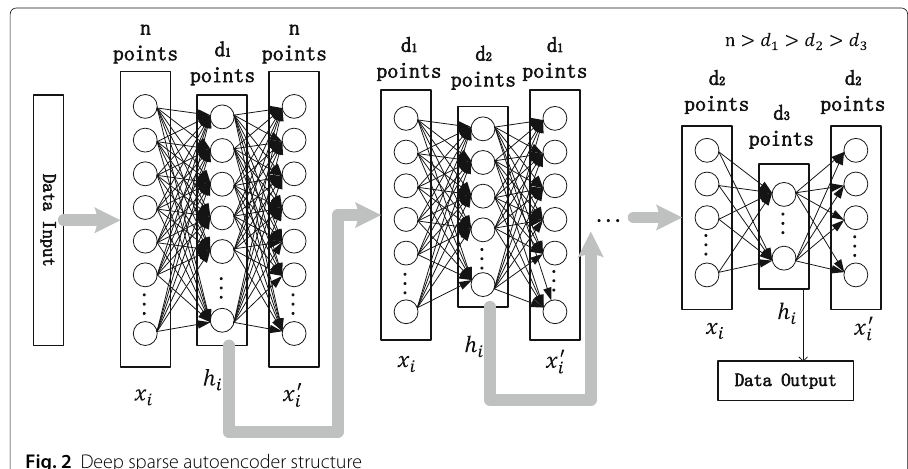
Fig. 2 Deep sparse autoencoder structure